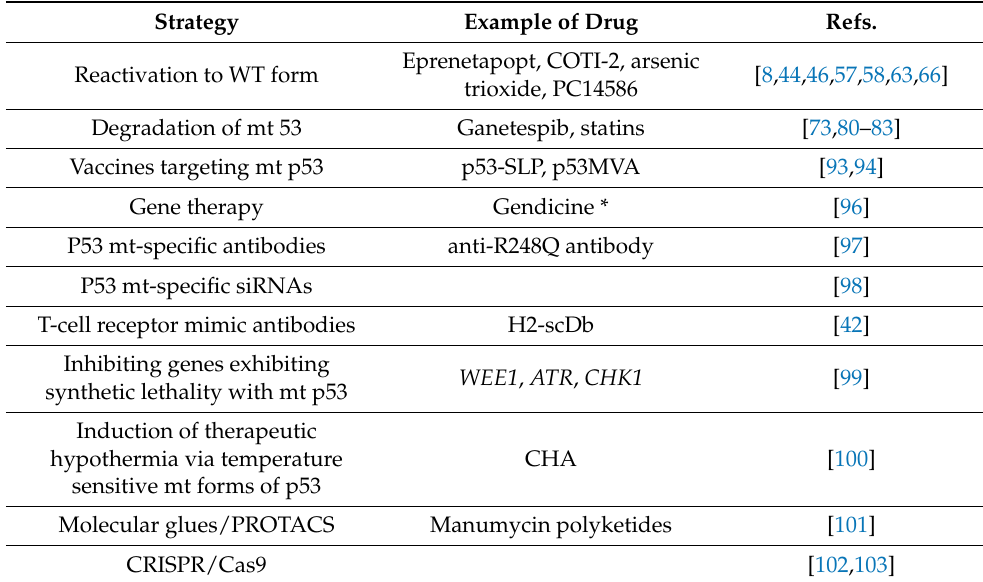
Table 2. Different strategies for targeting mutant p53 for cancer